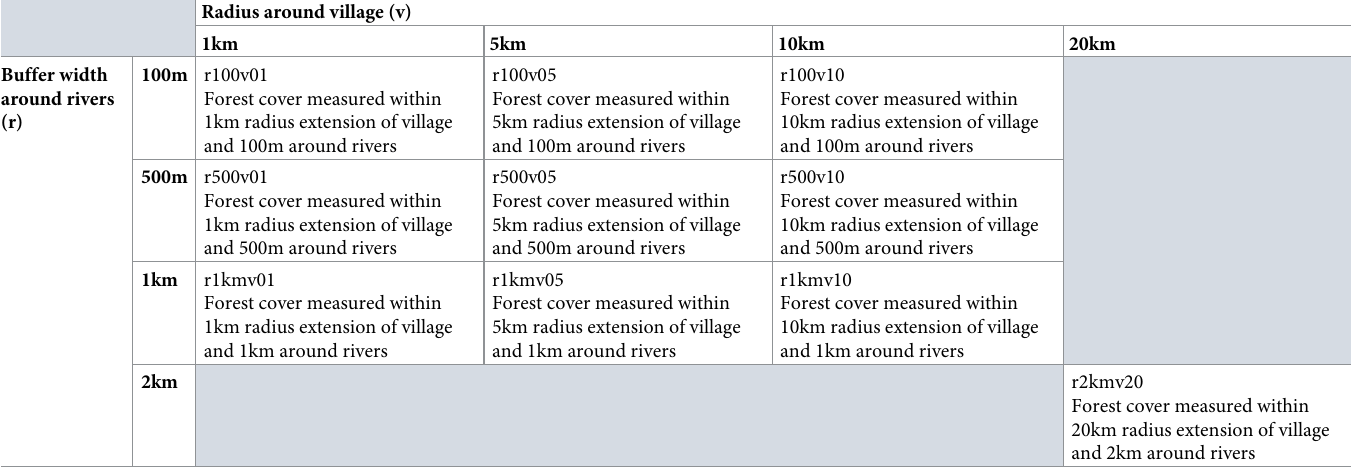
Table 1. Forest cover variables measured around rivers according to the radius extension around each village (v) and river buffer width (r). We included rivers that were within 1km, 5km, 10km, and 20km of each village. Forest density was measured within buffers of 100m, 500m, 1km, and 2km around rivers. Radius around village (v) 1km 5km 10km 20km Buffer width around